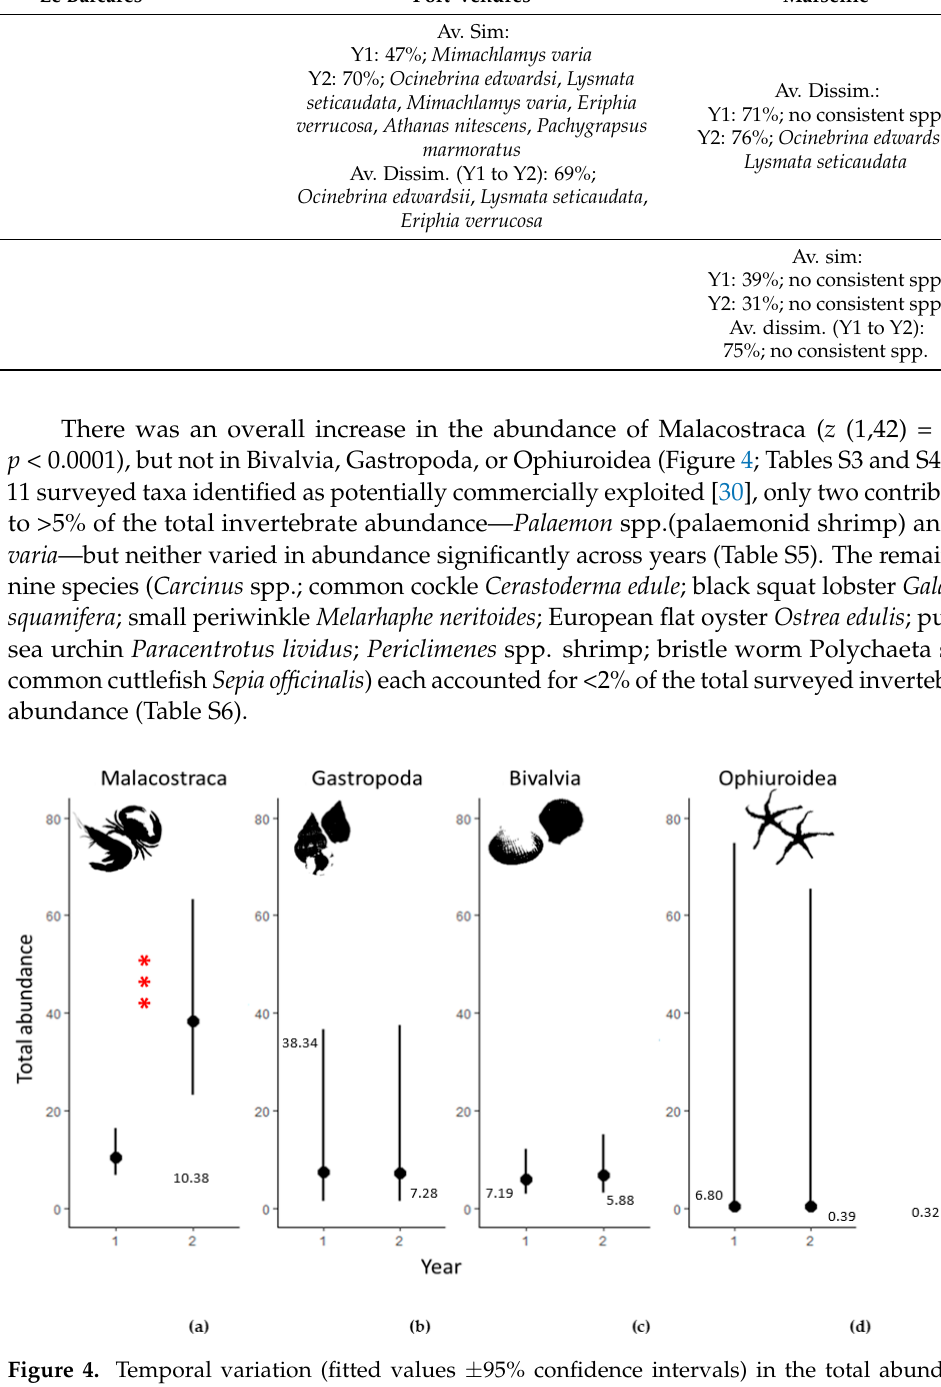
Figure 4. Temporal variation (fitted values ± 95% confidence intervals) in the total abundance (number of individuals/0.1m3 of artificial structure) of ( a ) Malacostraca; ( b ) Gastropoda; ( c ) Bivalvia; and ( d ) Ophiuroidea in surveyed Dock Biohut structures within Year 1 and Year 2 since installation. Signi fi cant di ff erences between time periods are indicated with asterisks (red *** p < 0.001).